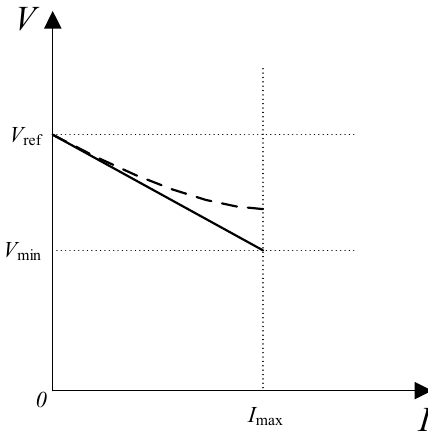
Figure 4. Diagram of improved droop curve.